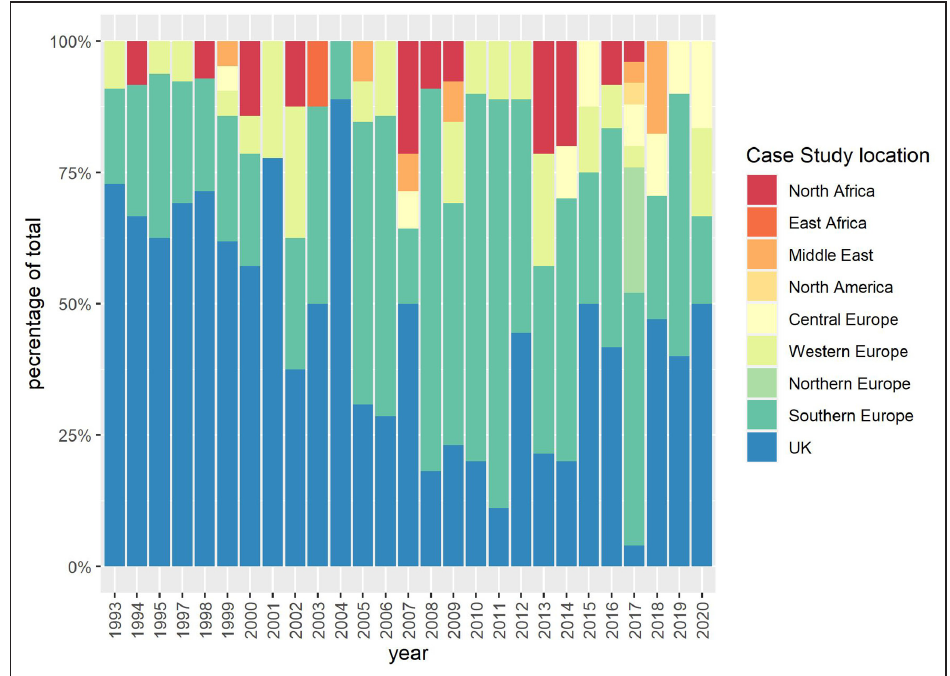
Figure 11: Location of case study locations for TRAC articles per year.